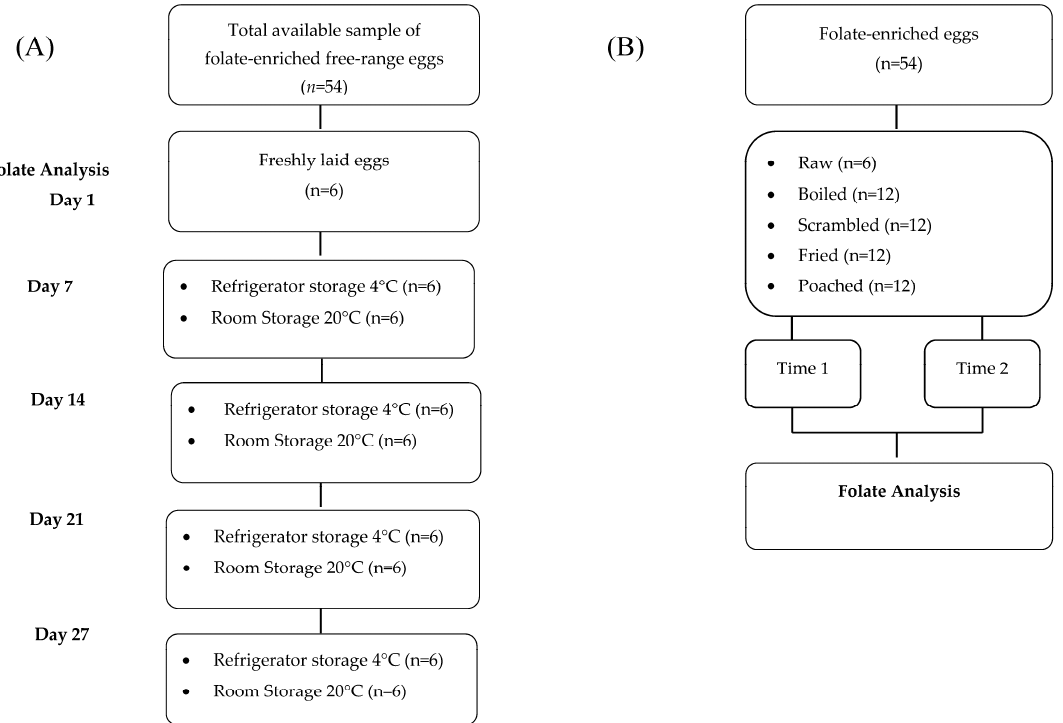
Figure 1. Flowchart of the experiments for the effect of storage ( A ) and cooking ( B ) on the stability of folate in folate-enriched eggs. Time 1 and time 2 refer to sampling times and correspond with the ‘soft’ and ‘hard’ consistency of cooked egg.